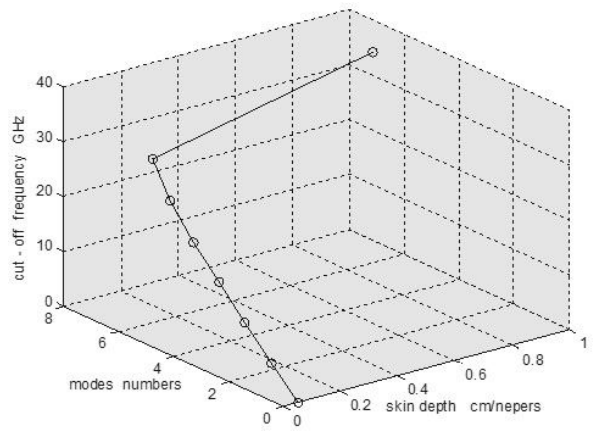
Figure 6: Number of modes, skin depth and cut-off frequency at a specified